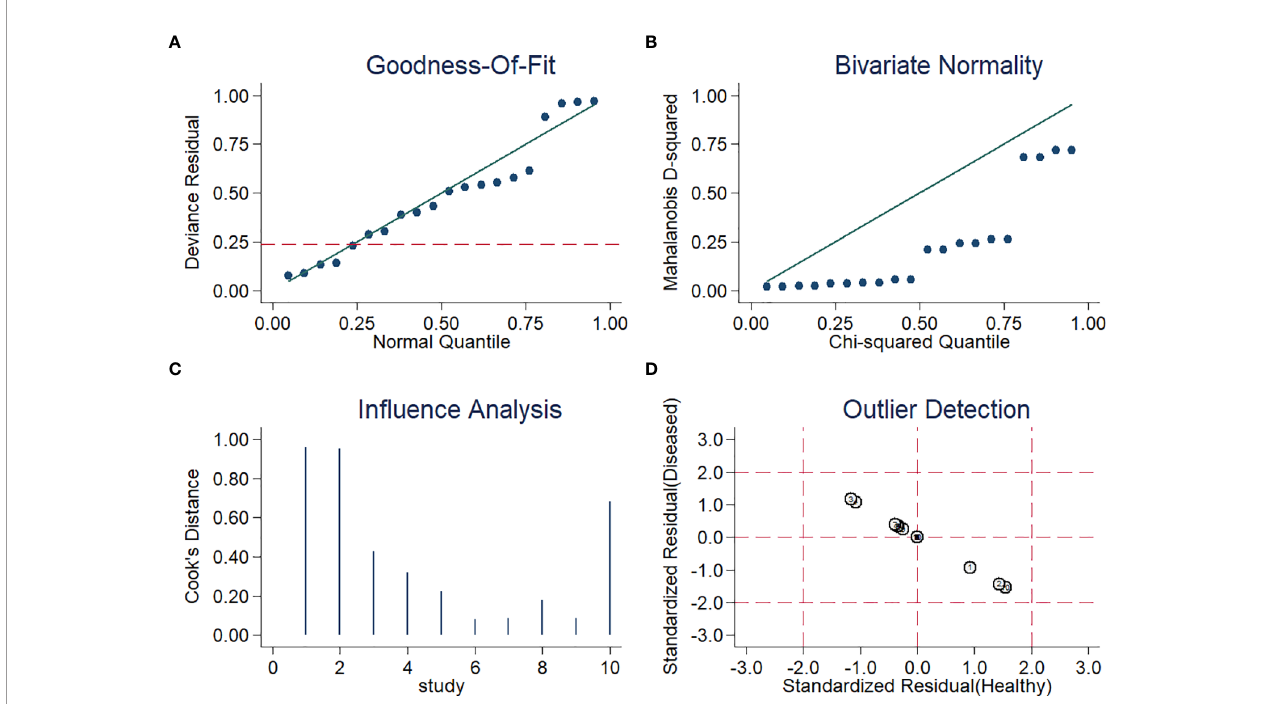
FIGURE 5 | Diagram of (A) Goodness-of- fi t (B) Bivariate normality (C) In fl uence analysis (D) Outlier